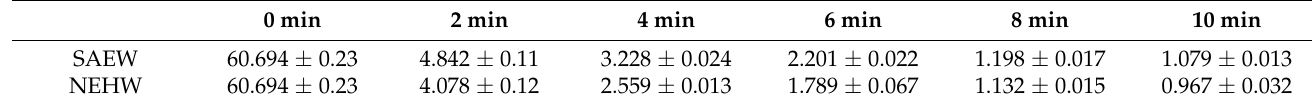
Table 3. The residual eRNA content in the biofilm of Listeria monocytogenes in each treatment. 0 min